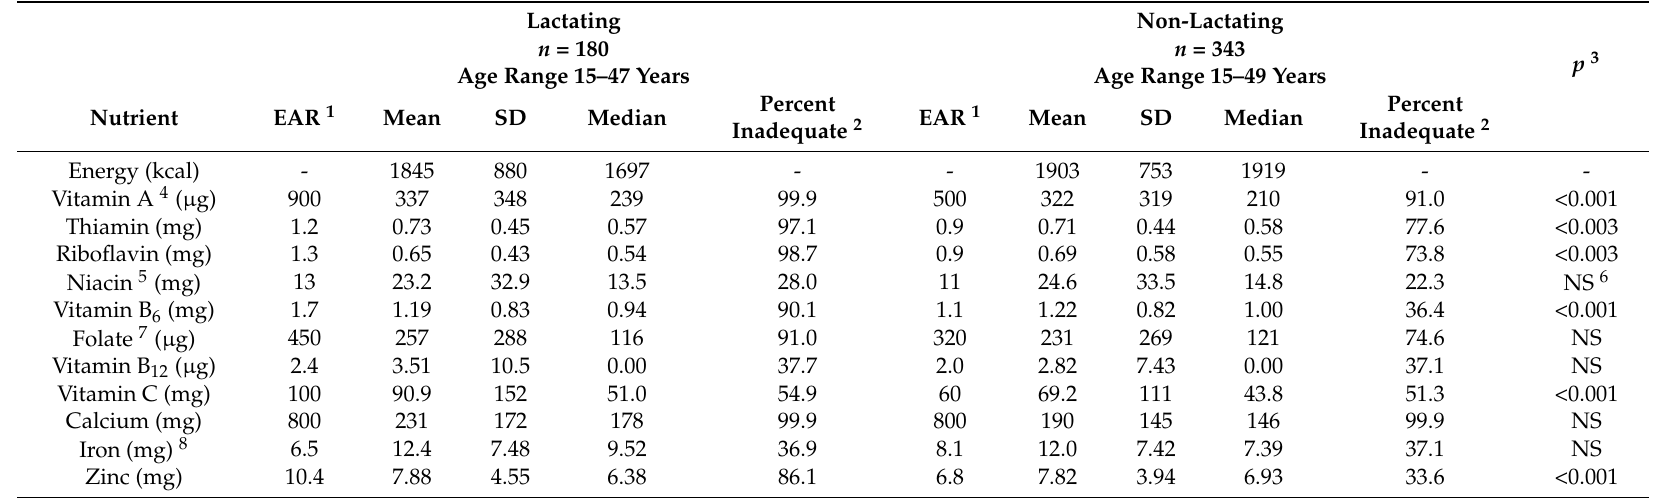
Table 3. Energy and micronutrient intakes of lactating and non-lactating Zambian women from 24-h dietary recall records.